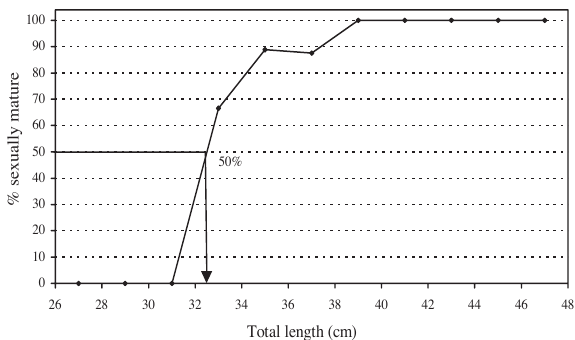
F IG . 3. – Sexual maturity curve of gilthead seabream as a function of total length in Mellah lagoon. The arrow indicates the total length at which 50% of fish were sexually mature. 99 fish were sampled in the months of November and December.